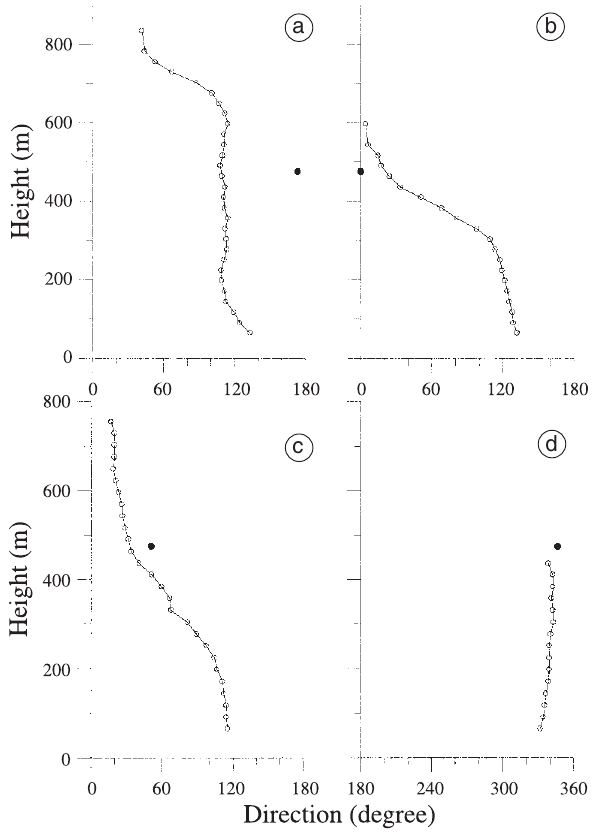
Fig. 4a-d. Typical 1 h averaged wind profi les (circle) observed at Ny-Ålesund, the wind direction measured at the Zeppelin research station (full dot) is given for comparison. a) April 7 between 2000-2100 ST; b) April 6 between 0900-1000; c) April 5 between 1900-2000; d) April 5 between